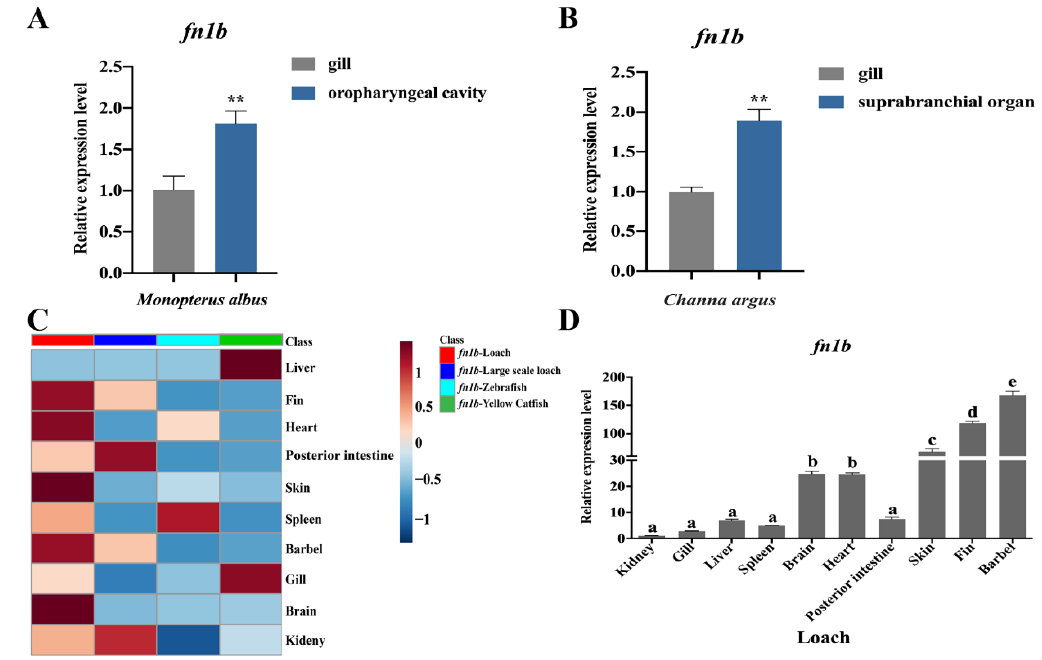
Figure 5. fn1b expression levels. ( A ) Expression levels of fn1b in the gill (aquatic breathing organ) and oropharyngeal cavity (an air-breathing organ) of rice-field eel Monopterus albus were calculated using the 2 − ∆∆ CT method. β -actin was used as the reference gene for normalization. ( B ) Expression levels of fn1b in gill and suprabranchial organ (an air-breathing organ) from snakehead fish Channa argus were calculated using the 2 − ∆∆ CT method. β -actin was used as the reference gene for normalization. ( C ) Tissue expression levels of fn1b in loach, large-scale loach, zebrafish, and yellow catfish. MetaboAnalyst5.0 was used for constructing the heat map. ( D ) Comparison of fn1b relative expression across different tissues from the loach ( Misgurnus anguillicaudatus ). Tissue expression levels of fn1b in loach were calculated using the 2 − ∆∆ CT method. β -actin and gapdh were used as reference genes for normalization. fn1b , fibronectin 1b; gapdh , glyceraldehyde-3- phosphate dehydrogenase. Different letters above error bars indicate significant difference among different tissues ( p < 0.05). ** very significant difference ( p <